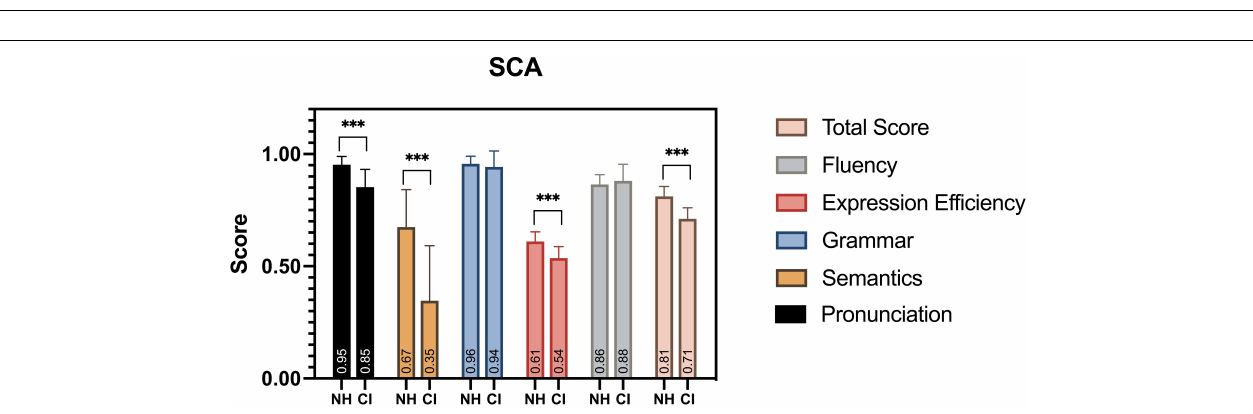
FIGURE 9 | Between-group contrast of average oxygen-hemoglobin concentrations (HbO) envelopes under strong-prosodic (SP) and weak-prosodic (WP) conditions. (A) Hemodynamic responses to SP by both groups in channels 5, 8, 14, and 16. Higher activation by normal hearing (NH) group was found in time window 2–7 s in Ch5 [ F (1,44) = 5.186, p FRD - cor = 0.028], Ch14 [ F (1,44) = 9.367, p FRD - cor = 0.004], and Ch16 [ F (1,44) = 10.162, p FRD - cor = 0.003]; time window 7–12 s in Ch5 [ F (1,44) = 5.084, p FRD - cor = 0.029], Ch14 [ F (1,44) = 9.736, p FRD - cor = 0.003], and Ch16 [ F (1,44) = 11.506, p FRD - cor = 0.001]; and time window 12–18 s in Ch8 [ F (1,44) = 8.994, p FRD - cor = 0.004]. (B) Under WP, higher activation by NH group was found in time window 2–7 s in Ch5 [ F (1,44) = 5.743, p FRD - cor = 0.021], Ch13 [ F (1,44) = 5.185, p FRD - cor = 0.028]; and time window 7–12 s in Ch5 [ F (1,44) = 4.483, p FRD - cor = 0.04], Ch7 [ F (1,44) = 5.932, p FRD - cor = 0.019], and Ch8 [ F (1,44) = 6.606, p FRD - cor = 0.014].